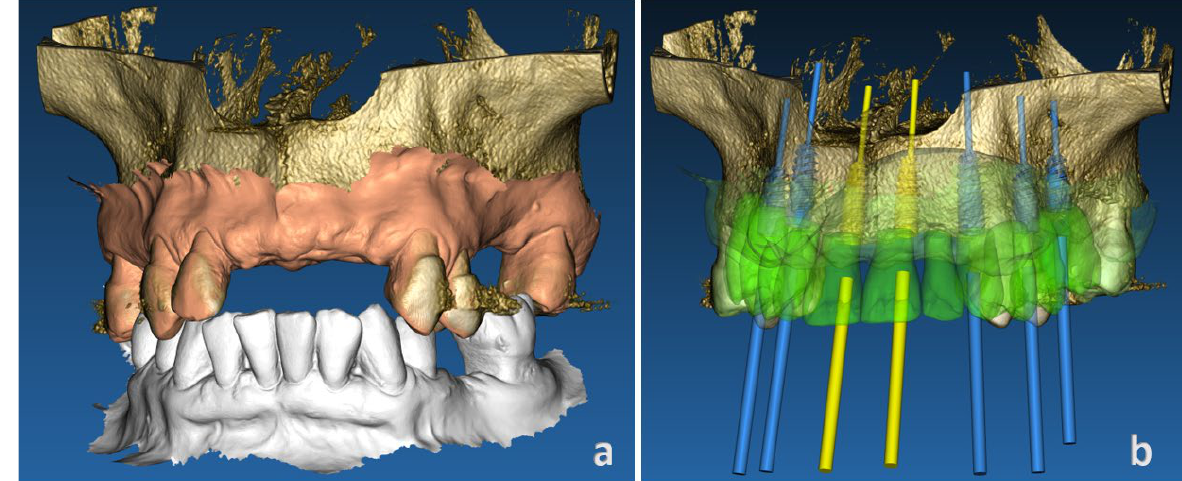
Figure 3. DICOM and STL files matching ( a ) with surgical and prosthetic project ( b ).